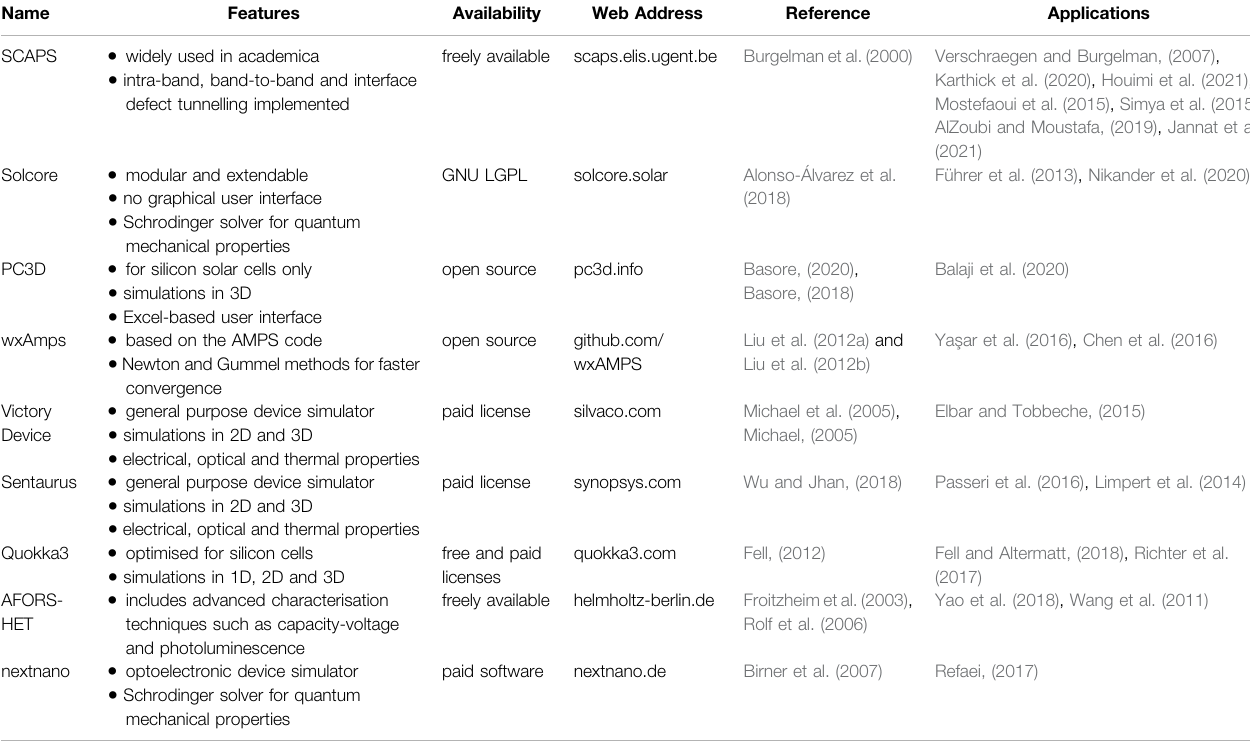
TABLE 1 | A non-exhaustive list of solar cell device simulation tools. The table allows a comparison of the key features and availability. Unless otherwise stated, the simulations are one-dimensional and a graphical user interface is available. ‘ Open source ’ indicates that the source code is available for free download. ‘ Freely available ’ indicates that the compiled software is available for free download. Note that Solcore is free to use and is distributed with an open source license, GNU LGPL (gnu.org/ licenses/lgpl-3.0). We also include signposts for further information: a project web address and a reference in the academic literature. Finally we list selected publications in which the software has been applied.